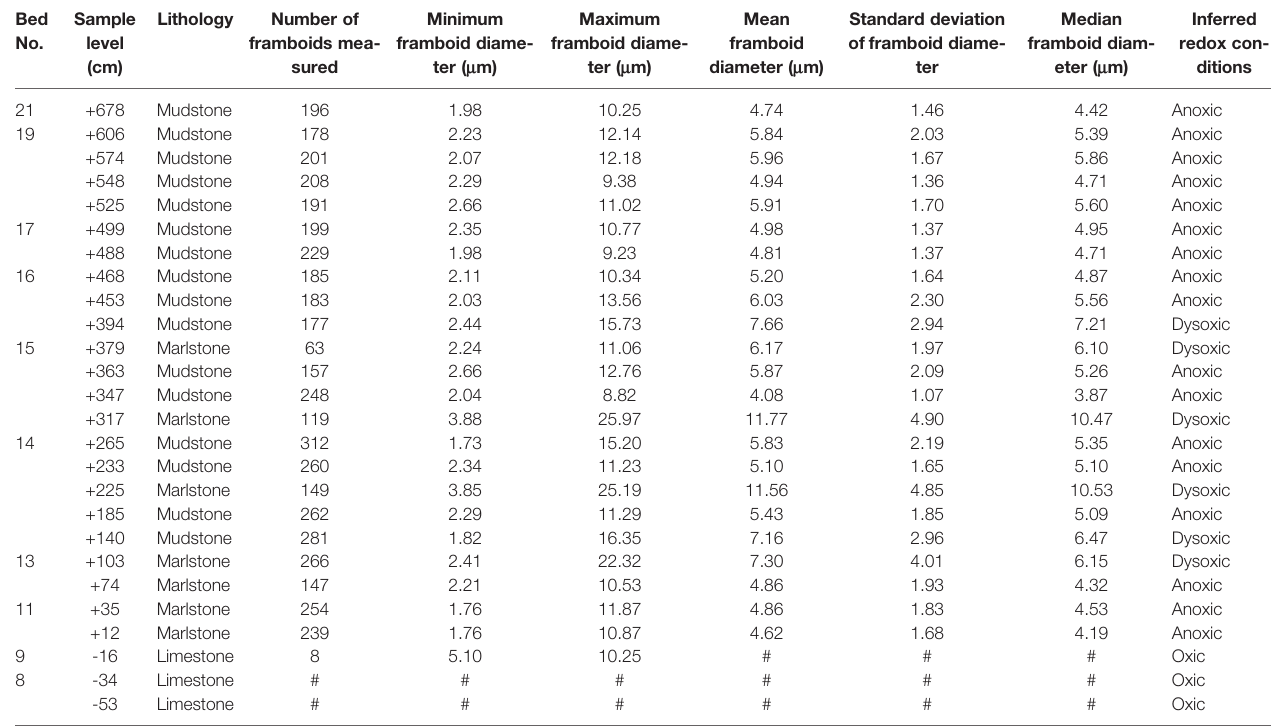
Sample level “ -53 ” means 53 cm below the fi rst mass extinction horizon (MEH 1), and “ +678 ” means 678 cm above the MEH 1. “ # ” means no